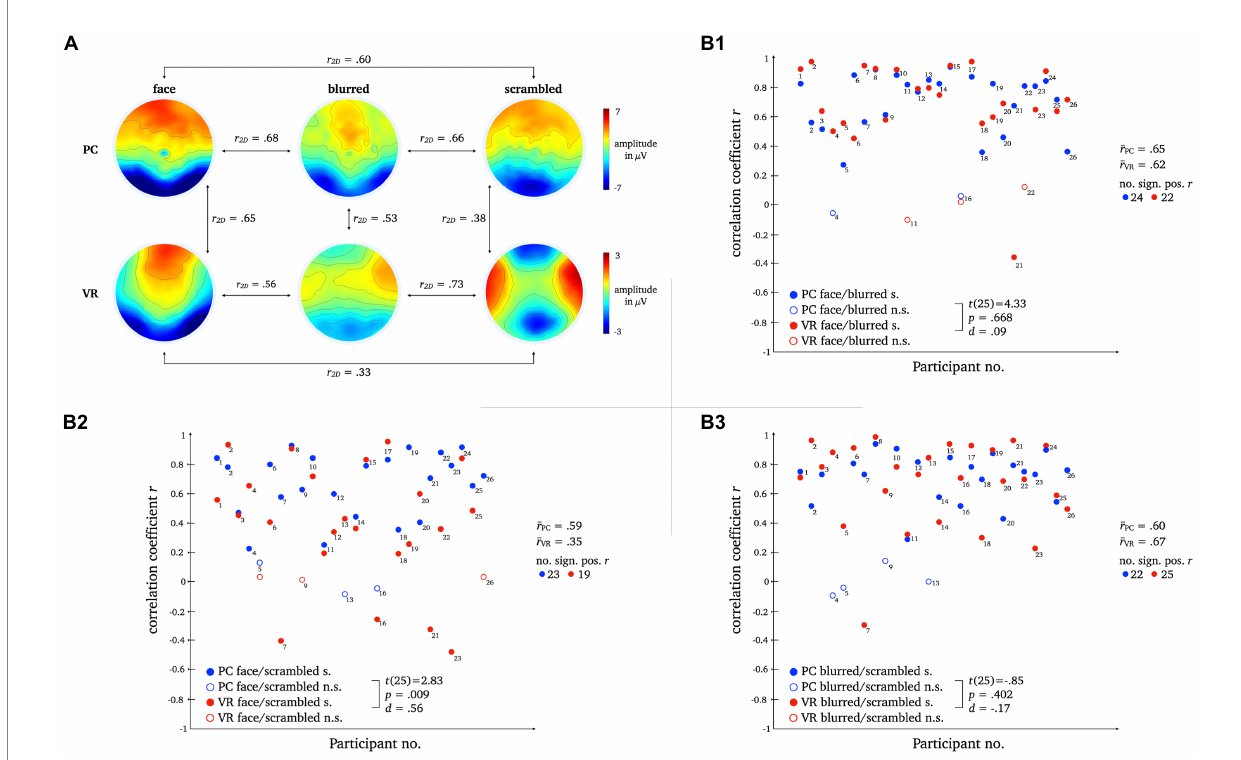
FIGURE 11 L2 topographies with 2D-correlation coefficient r for within and between modality comparisons [panel A ]. The scatter plots illustrate individual correlation coefficients for stimulus type comparisons between modalities: Face vs. Blurred [panel B1 ], Face vs. Scrambled [panel B2 ] and Blurred vs. Scrambled [panel B3 ]. T -Test statistics, mean correlation coefficients and number of significant correlation coefficients are